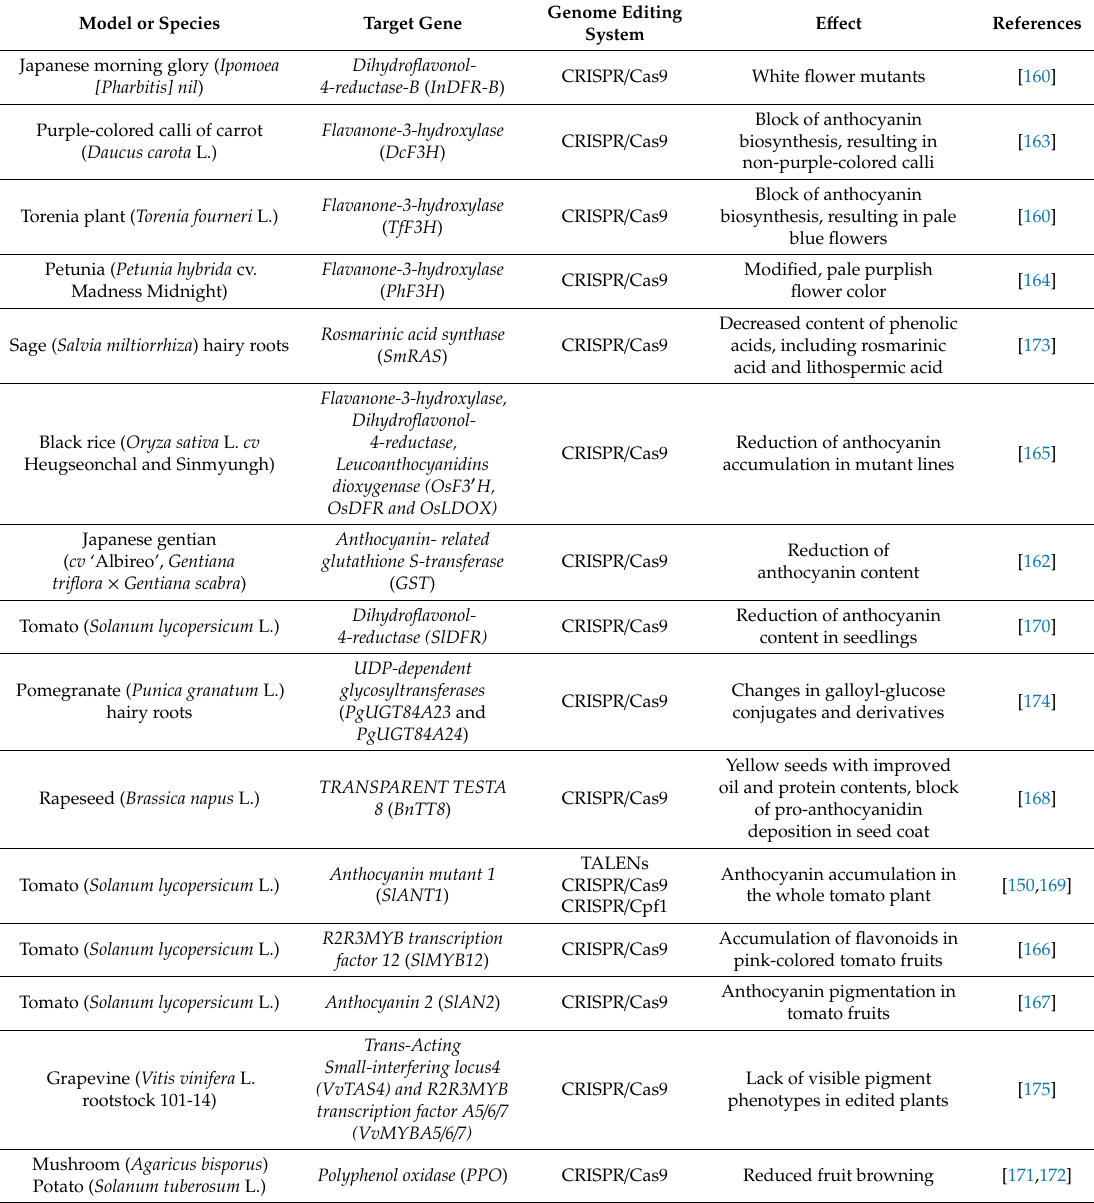
Table 4. Examples of genome editing systems for the study, blockage, enrichment or preservation of the polyphenol content in plant models or crop